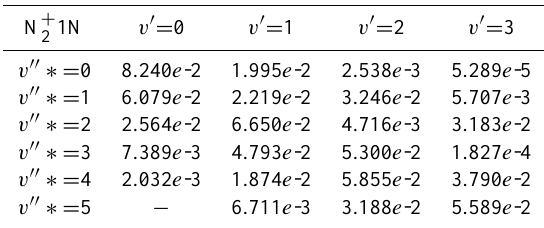
Table 4. N + X resonance absorption efficiencies to N + 2 of [ph/s] per ion in the X